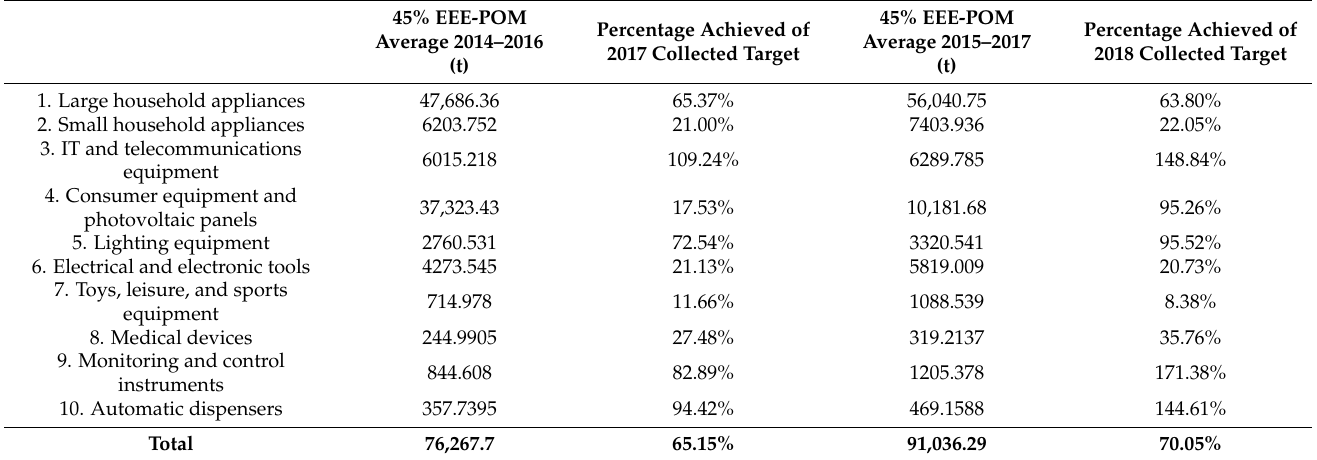
Table 10. Percentage in which the e-waste collection target was achieved in Romania (years 2017 and 2018) was calculated by the authors according to the information of